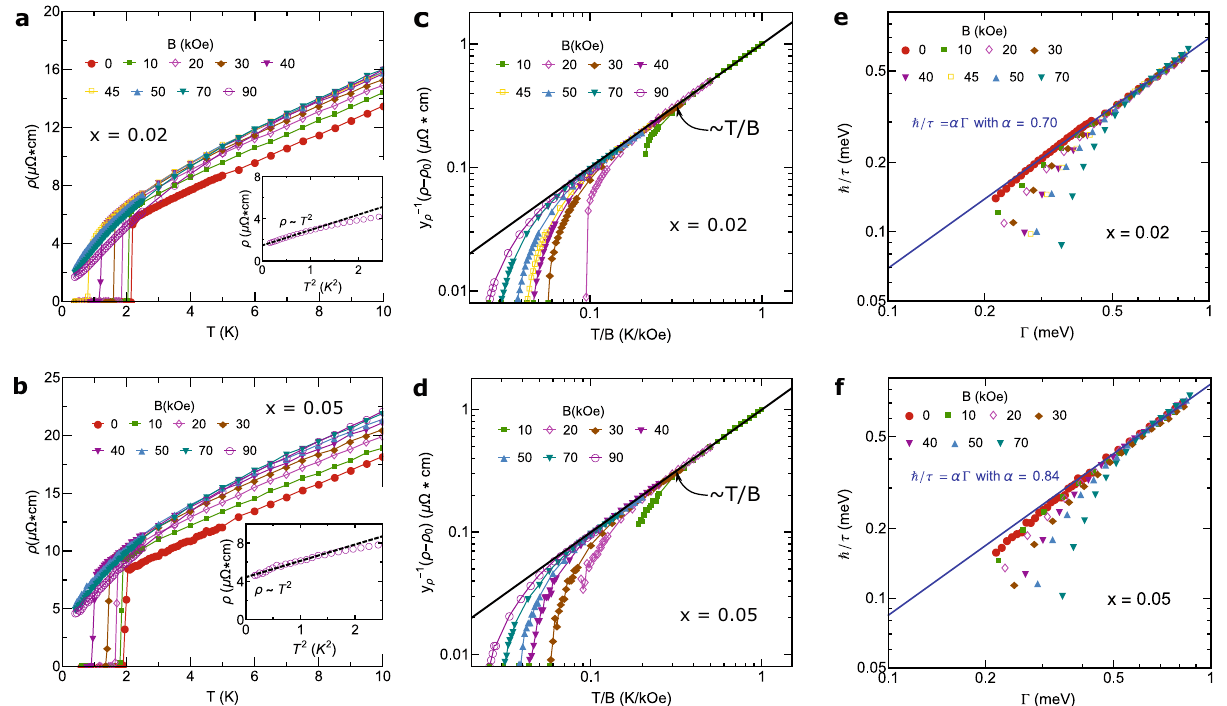
q ffiffiffiffiffiffiffiffiffiffiffiffiffiffiffiffiffiffiffiffiffiffiffiffiffiffiffiffiffiffiffiffiffiffi resistivity exhibits a linear-in- T dependence show an universal scaling function ℏ / τ = α Γ (blue solid lines), with Γ (cid:3) ð k B T Þ 2 + ð l μ B B Þ 2 , τ being the relaxation time, μ B beingtheBohrmagneton,and l =0.67beinga fi ttingparameter 43 .In e and f ,the β bandofpureCeCoIn 5 ,withthesamebandparametersusedinTable1,istakeninto account in performing the Γ scaling of resistivity. The extracted α coef fi cients shown in e and f are consistent with that shown in Table